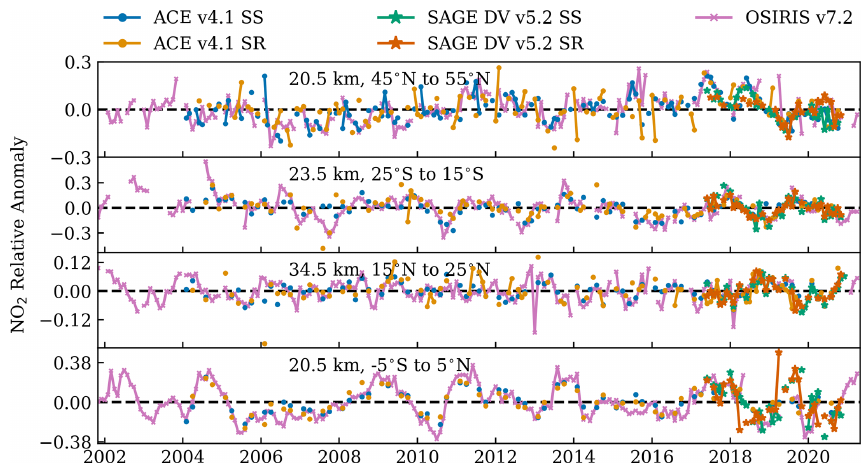
Figure 13. Anomaly time series comparing OSIRIS v7.2 to ACE v4.1 and SAGE III/ISS v5.2 DV for four latitude/altitude bins.